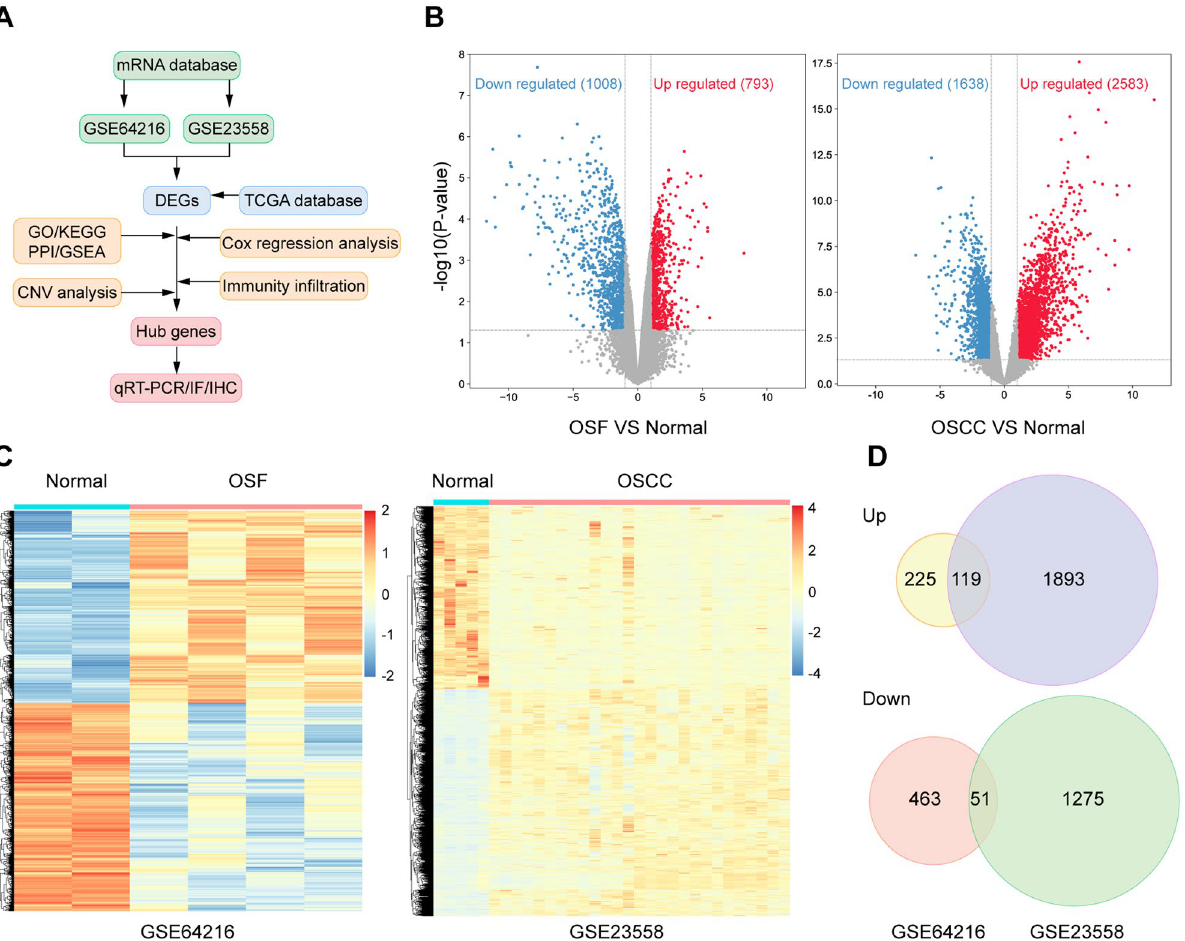
Figure 1. Identifcation of DEGs in GEO database. ( A ) Flow chart for identification of the hub genes connected to the transformation of oral submucous fibrosis (OSF) into oral squamous cell carcinoma (OSCC). DEGs, differentially expressed genes; GSE64216, including four oral submucous fibrosis patients and two controls; GSE42589, containing 27 OSCC samples and five control samples; TCGA, The Cancer Genome Atlas database; GO, gene ontology analysis; KEGG, Kyoto Encyclopedia of Genes and Genomes analysis; PPI, protein–protein interaction analysis; GSEA, Gene Set Enrichment Analysis; CNV, copy number variations; IF, immunofluorescence; IHC, immunohistochemistry. ( B ) The differentially expressed genes between Normal and OSF groups, Normal and OSCC groups in GSE64216 and GSE23558 analyzed by Volcano plots. Red, blue and gray color indicates high, low, and equal expression of mRNAs, respectively. ( C ) Heatmaps of differentially expressed genes in the GSE64216 and GSE23558. Red, high expression; blue, low expression. ( D ) The Venn diagram analysis of both down and both up-regulated DEGs in GSE64216 and